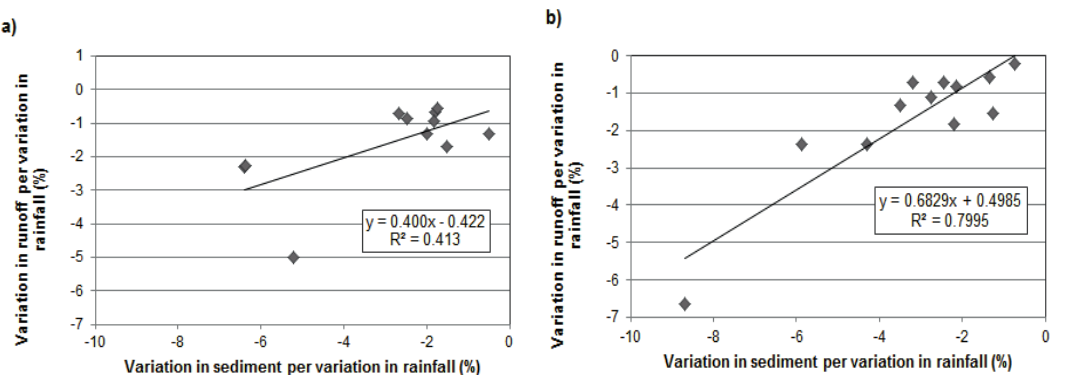
Fig. 3 Monthly variation in runoff and sediment related to 1% of change in precipitation for: (a) A2 scenario, (b) B2